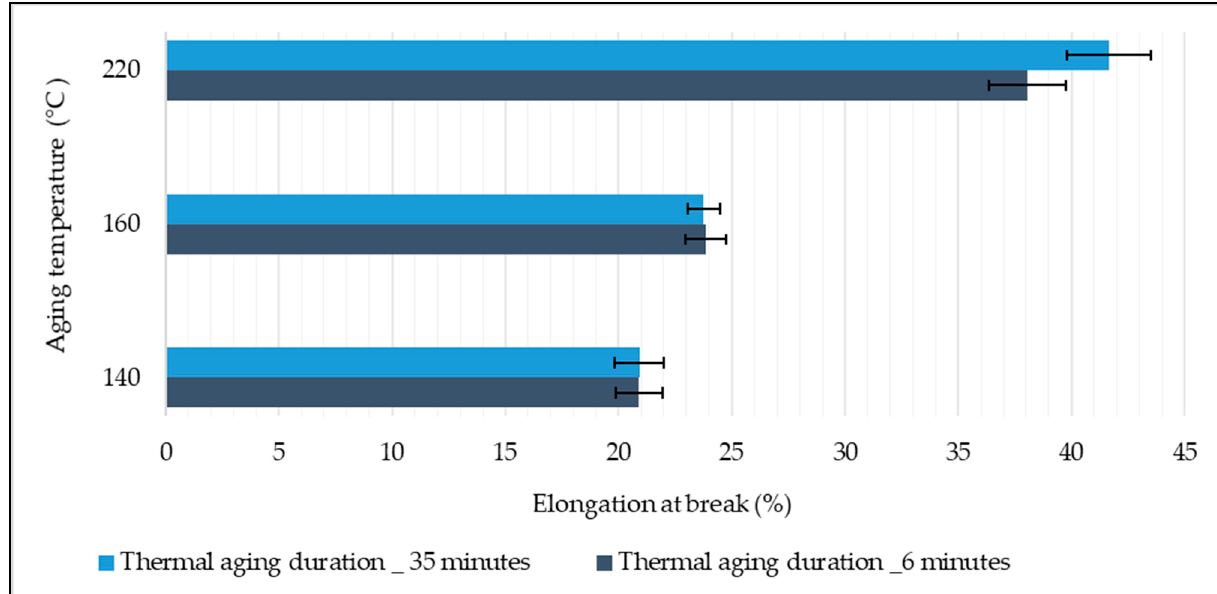
Figure 10. Effect of thermal aging on the elongation property of woven fabric.